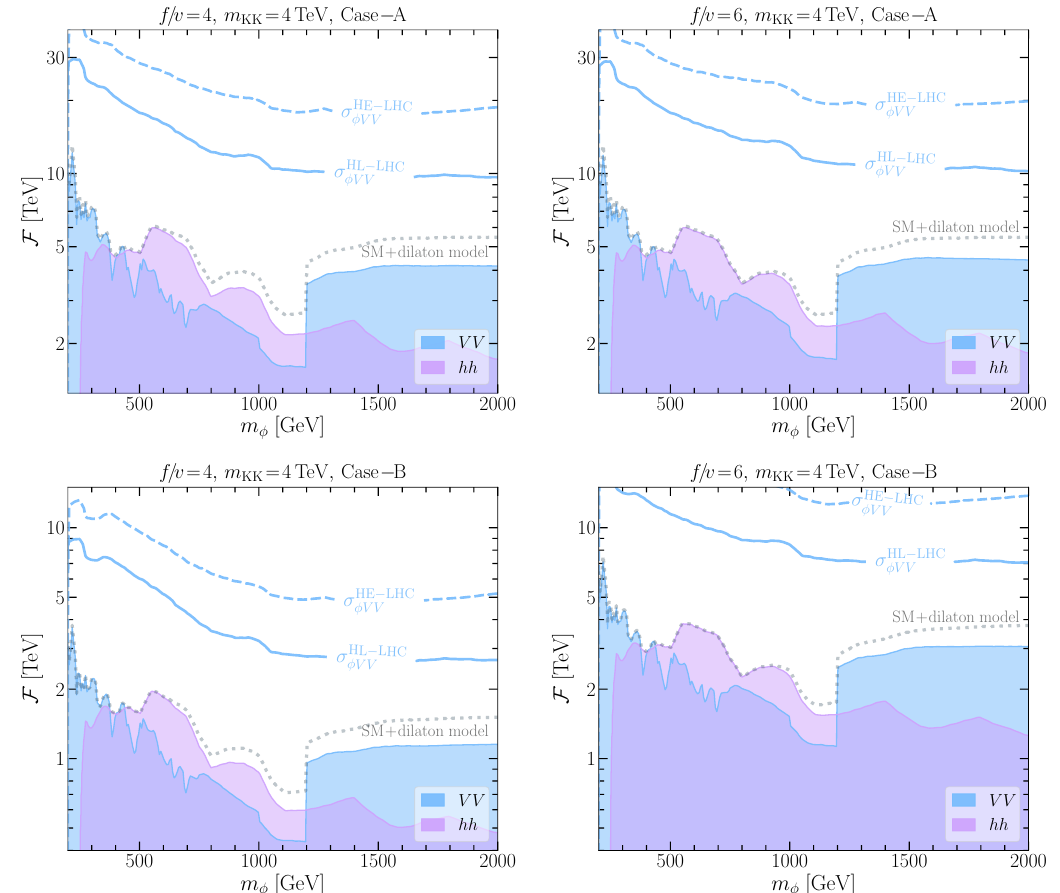
Figure 6 . The shaded regions show current LHC exclusion bounds from the dilaton cross sections to V V (blue) and hh (purple) on the VEV of dilaton as a function of dilaton/radion mass for F (cid:12)xed values of f=v = 4 and f=v = 6, with m KK = 4 TeV. The solid and dashed curves correspond to the HL-LHC ( p s = 14 TeV) and HE-LHC ( p s = 27 TeV) reach at 95% C.L. with integrated luminosity 3000 fb (cid:0) 1 ,